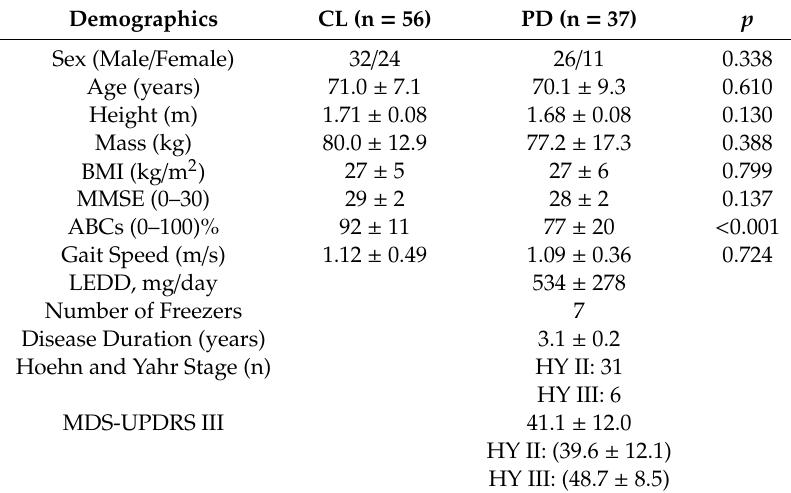
Table 1. Demographic and clinical outcomes for the PD and control